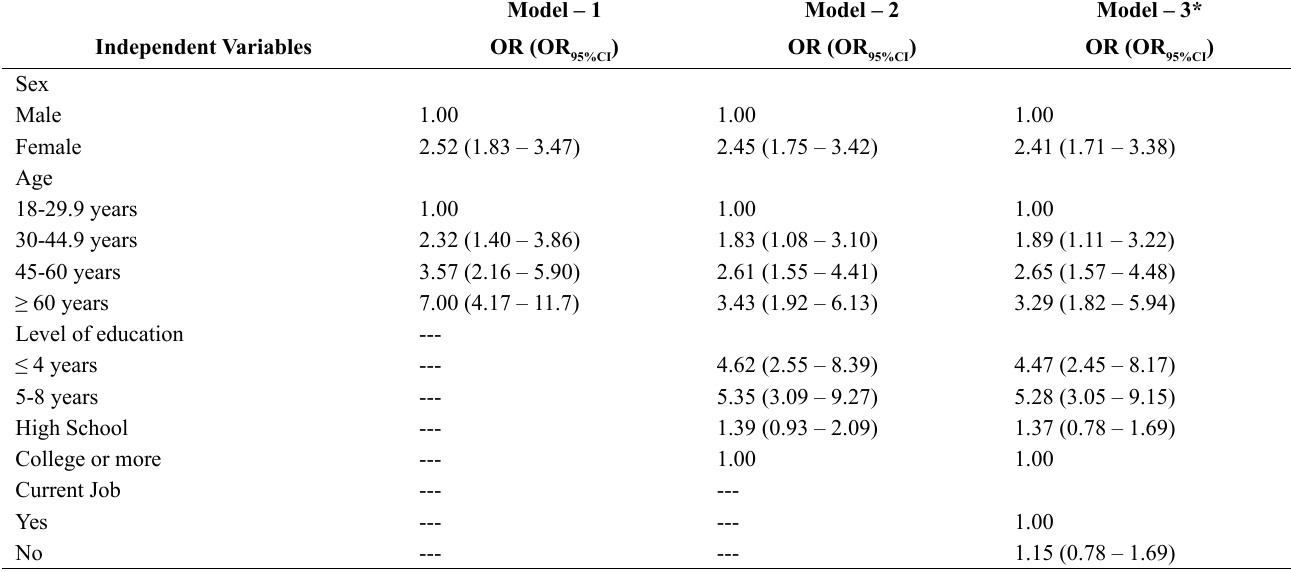
Table 3. Multivariable models for the association between non-participation in sports throughout life and independent variables among